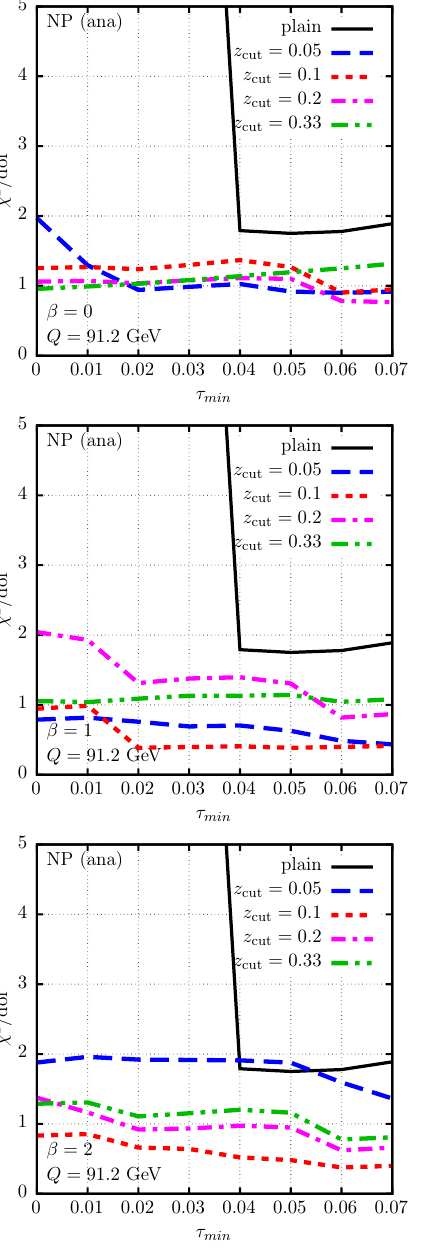
Figure 9. The best-(cid:12)t (cid:31) 2 =dof (left column) and (cid:11) s ( m Z ) (right column) values as a function of the lower bound of the (cid:12)tting range, (cid:28) min . Shown are results for plain thrust and for soft-drop thrust, using di(cid:11)erent combinations of the soft-drop parameters (cid:12) and z cut